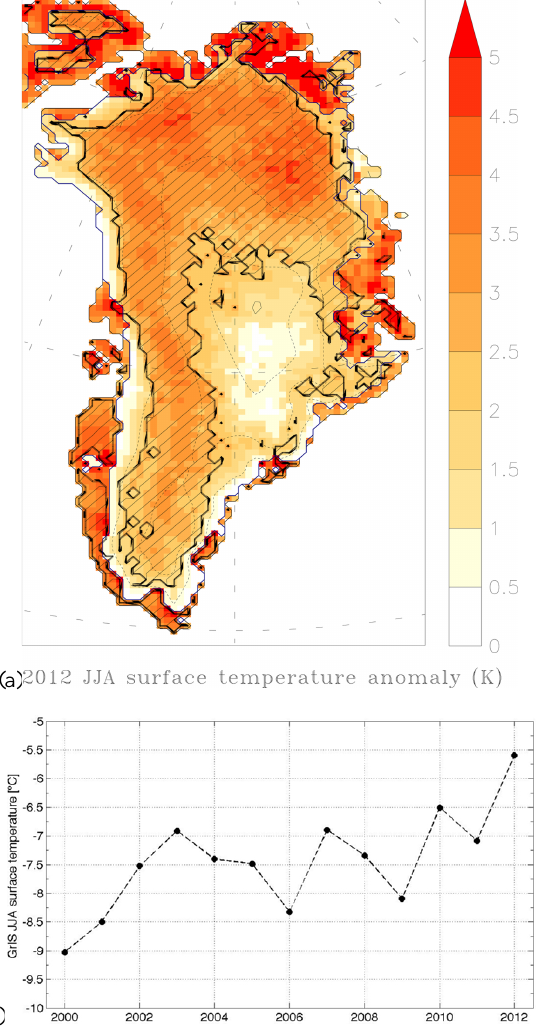
Fig. 1. (a) 2012 JJA surface temperature anomaly (1958–2011 base- line) simulated by MAR. Hatched areas indicate regions were the anomaly was above two standard deviations from the mean. (b) An- nual JJA mean surface temperature from MODIS averaged over the entire Greenland ice sheet for the period 2000–2012.